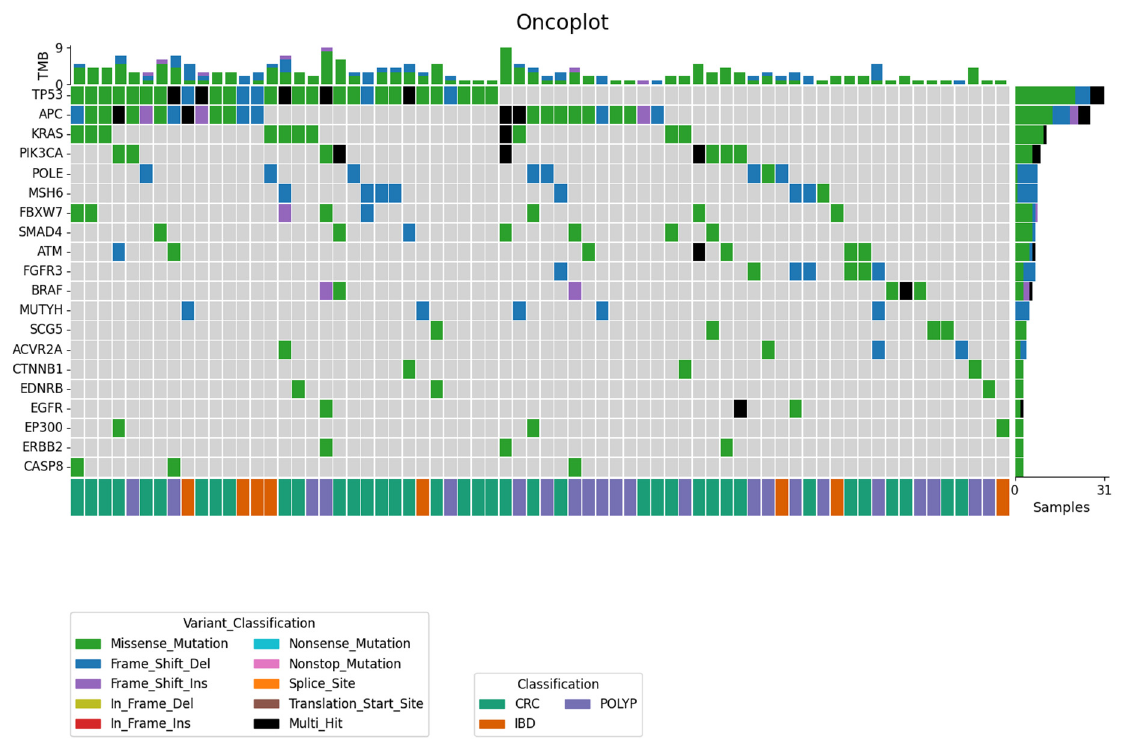
Figure 1. Oncoplot displays the somatic mutations distribution of the top highly mutated genes in different groups. Each column represents a sample, and it is classified according to the group by colors in the last row. Each row represents a particular gene with different variant classification.